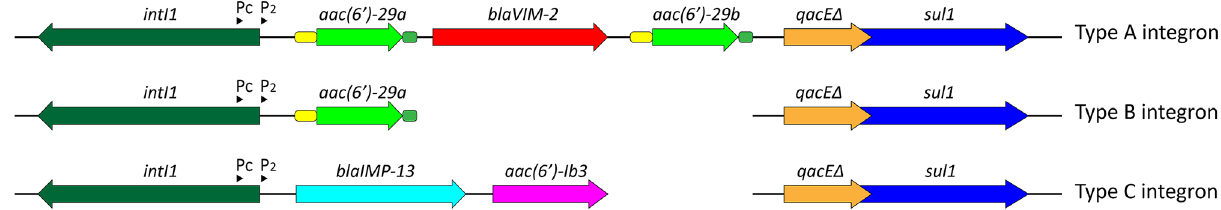
Figure 3. Class 1 integron compositions of Group 1 isolates. All Group 1 isolates except two carried a 3554 bp Type A integron containing the bla VIM-2 gene cassette flanked by aac(6 ′ )-29a and aac(6 ′ )-29b genes. Yellow and green squares flanking the aac(6 ′ )-29a/b genes denote identical sequences. The integron structure of the CIM- negative Group 1 isolate was identical to a Type A integron, but the bla VIM-2 and aac(6 ′ )-29b genes had been deleted (Type B). The IMP-13-encoding Group 1 isolate carried a different gene cassette composition (Type C). P , promoter located within the integrase gene ( intI1 ); aac(6 ′ )-29a , aac(6 ′ )-29b , and aac(6 ′ )-Ib3 , aminoglycoside resistance genes; bla VIM-2 and bla IMP-13 , carbapenem resistance genes; qacEΔ, incomplete quaternary ammonium compound resistance gene; sul1 , sulfonamide resistance gene. Figure was created using BioNumerics v7.6 and Adobe Illustrator 2020.